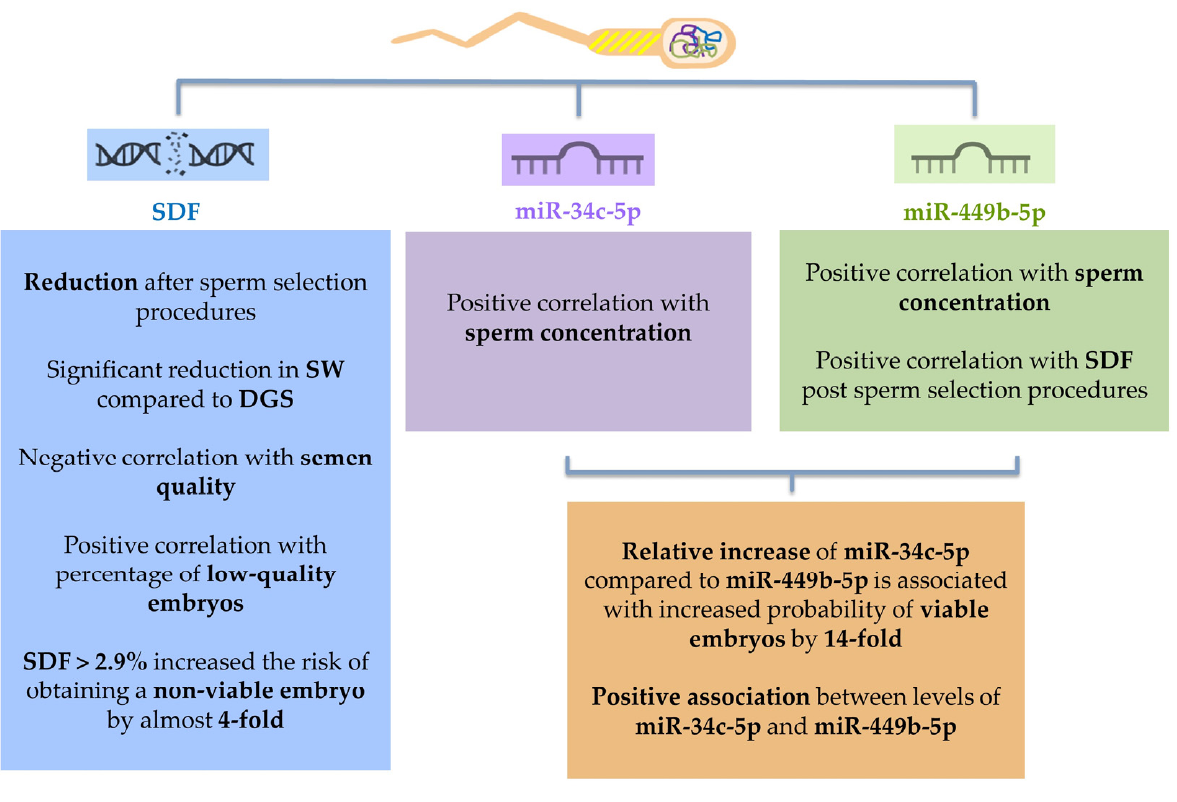
Figure 5. Summary of the study results.